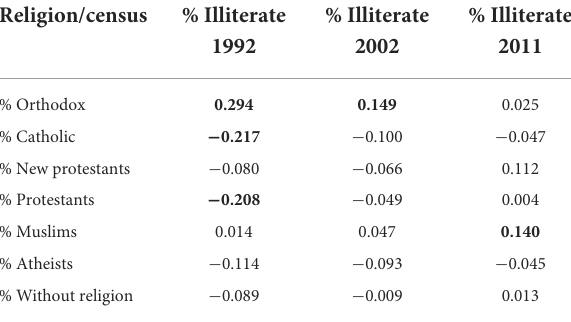
TABLE 5 Pearson correlation coefficient between illiteracy ratio and religion (r).